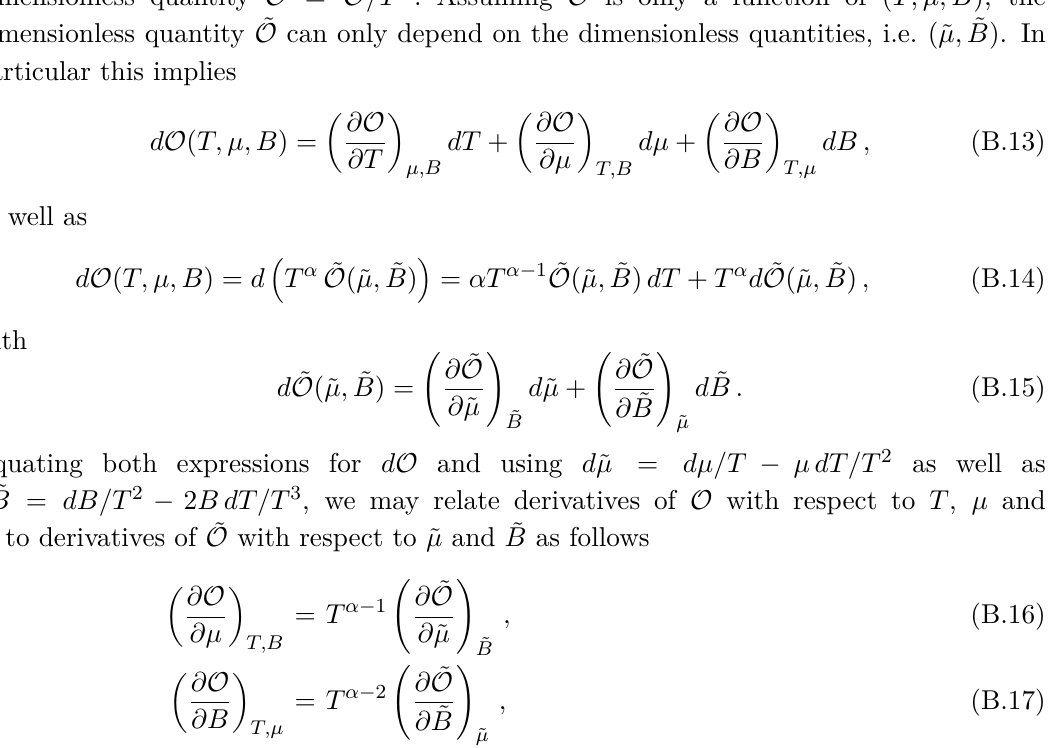
to the form given in eq. (3.16) (solid